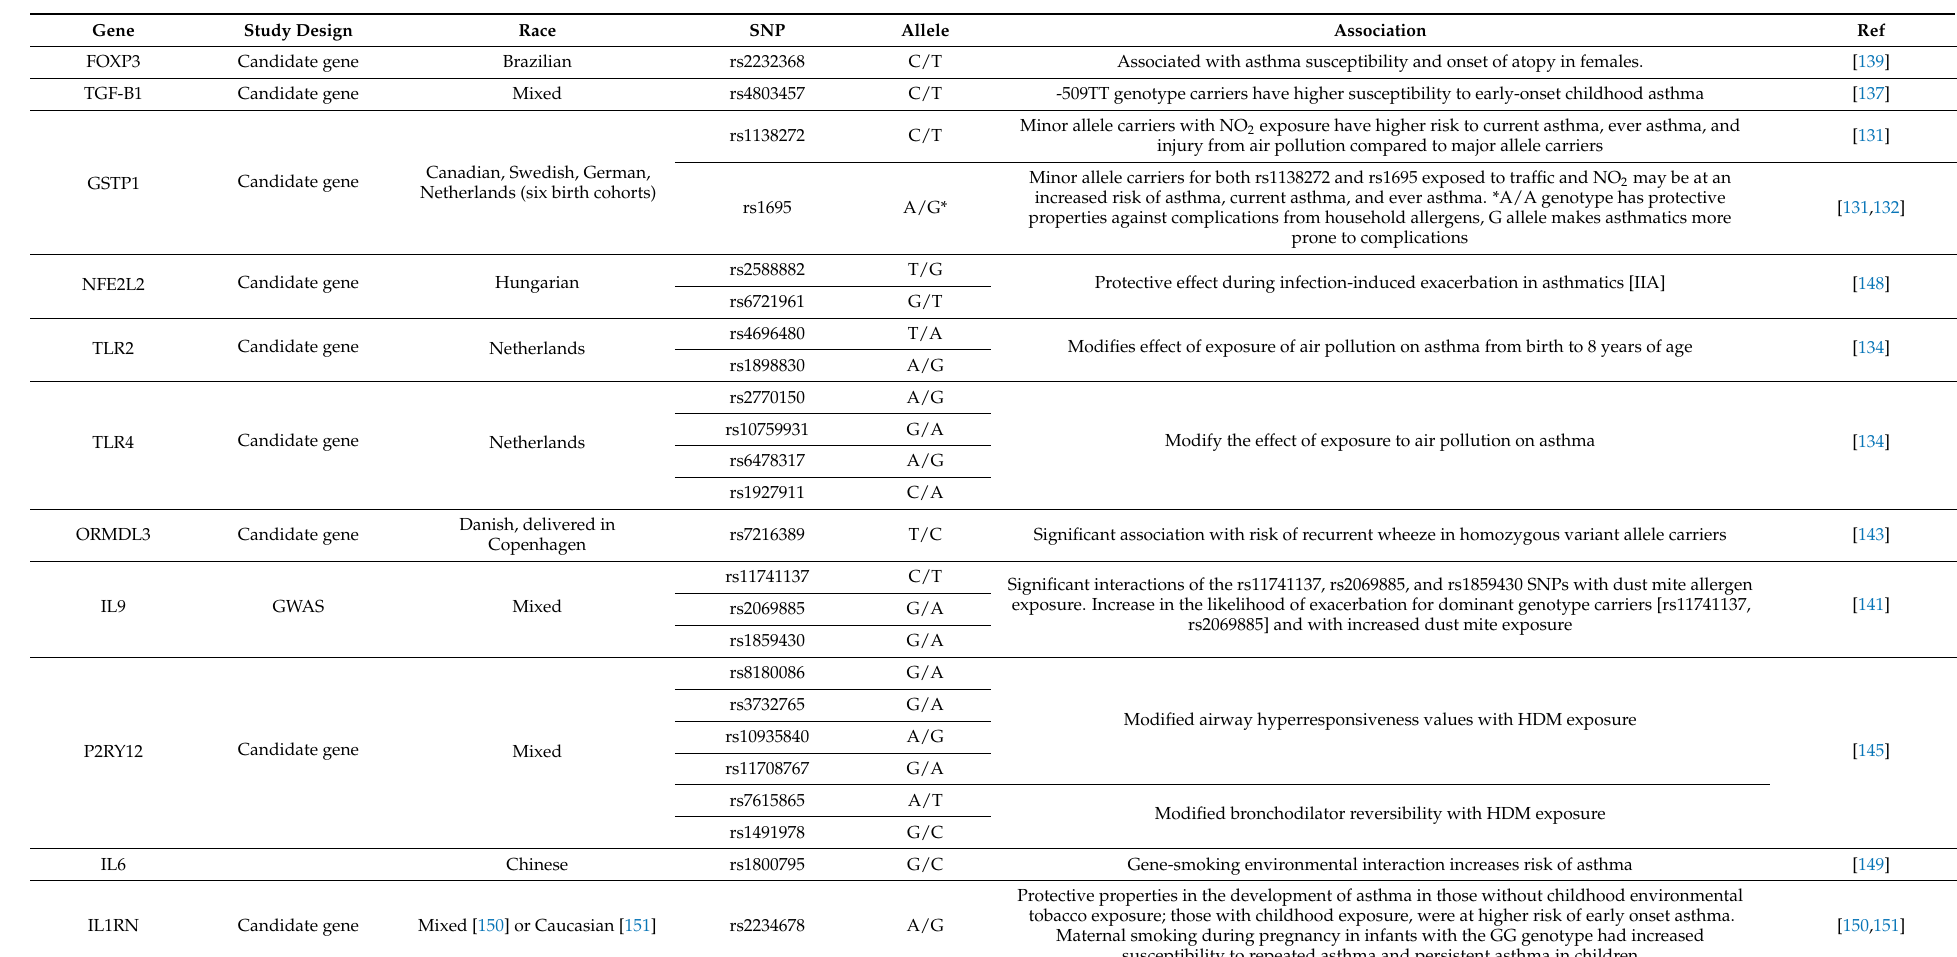
Table 3. Combined effects of gene-environmental